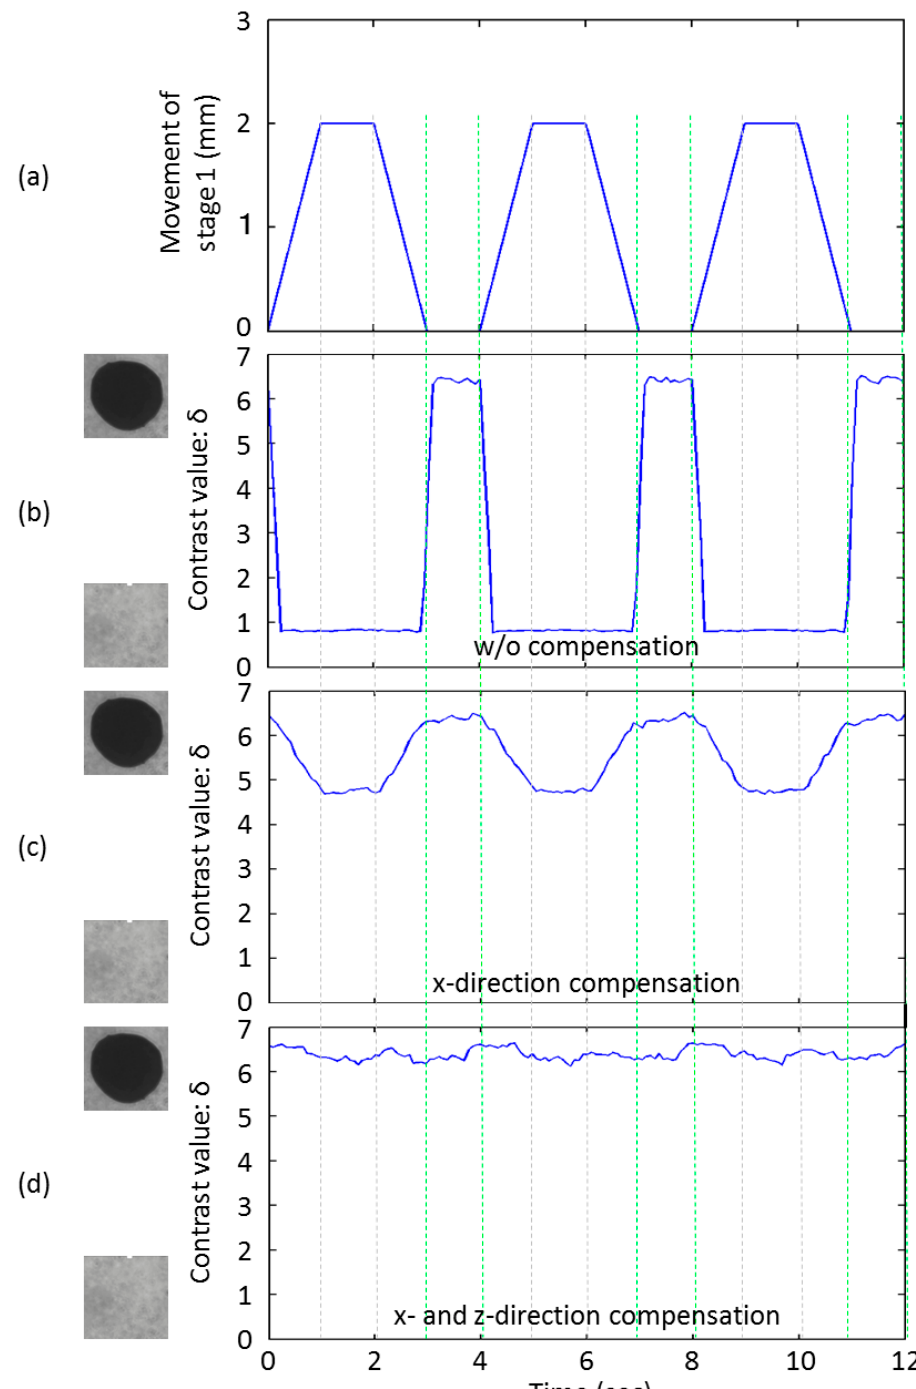
Figure 10. Stretch waveform of stage 1 and calculated contrast for each condition. In this experiment, maximum δ x and δ z were 1.25 mm and 0.11 mm, respectively. ( a ) The chamber stretching waveform by stage 1. ( b ) Contrast values of point 3 during the stretching/relaxation process without compensation (corresponding to Figure 9a). ( c ) Contrast values with the compensation in the horizontal direction (stage 2) (corresponding to Figure 9b). ( d ) Contrast values with the compensation by stage 2 and 3 (corresponding to Figure 9c).